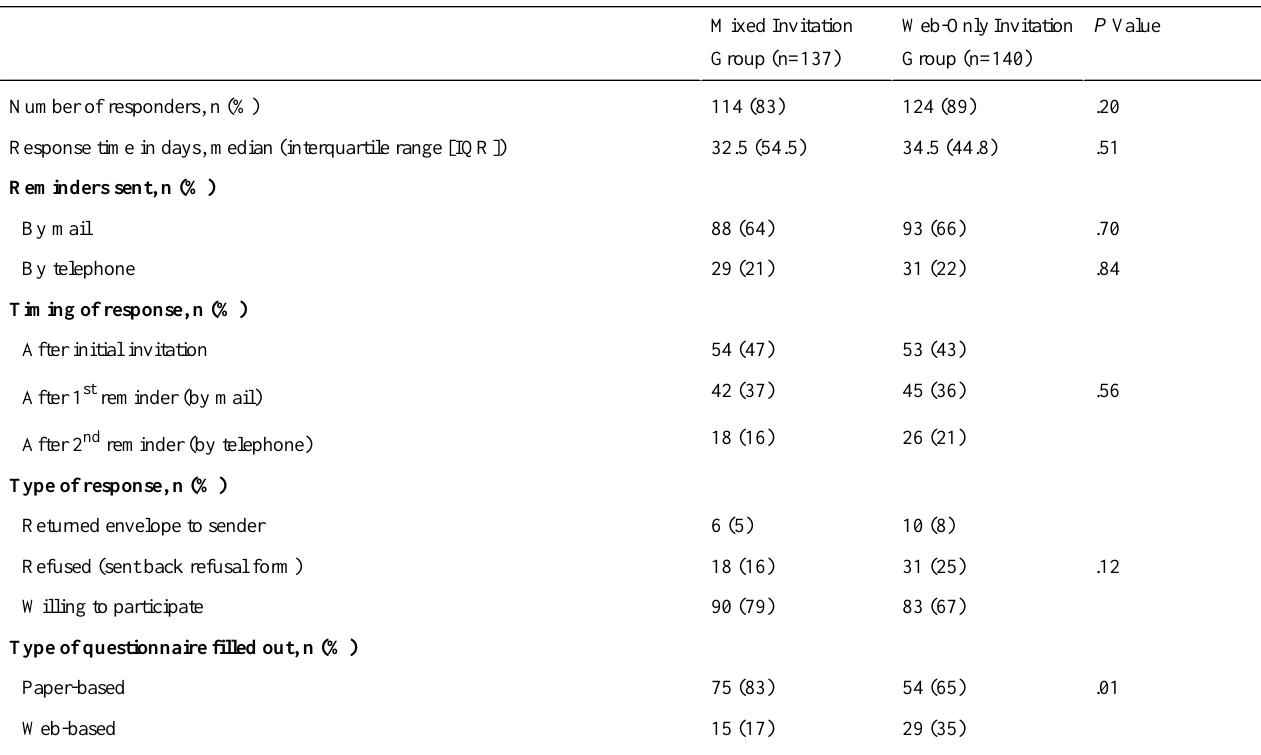
Table 1. Response characteristics of the participants receiving the mixed invitation and the Web-only invitation (n = 277)